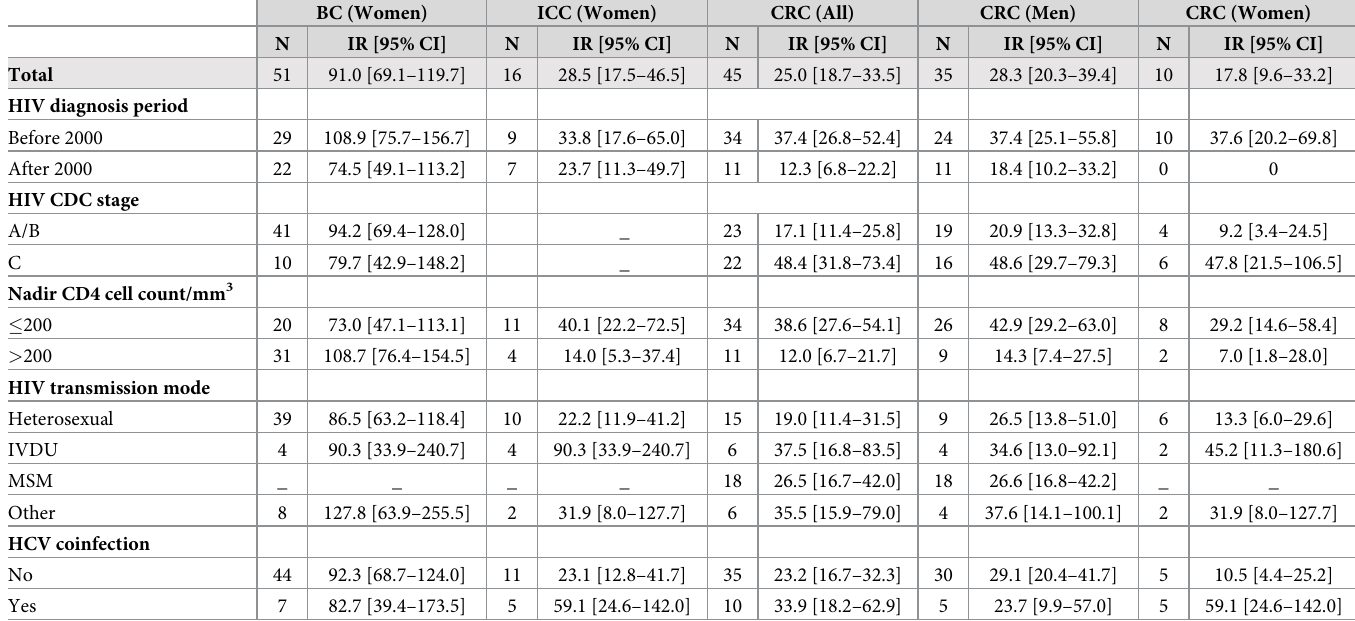
Table 2. Incidence rates of cervical, breast and colorectal cancers—overall and according to patient profile—in the Dat’AIDS cohort between 01 January 2010 and 31 December 2015 (N = 44,642). BC